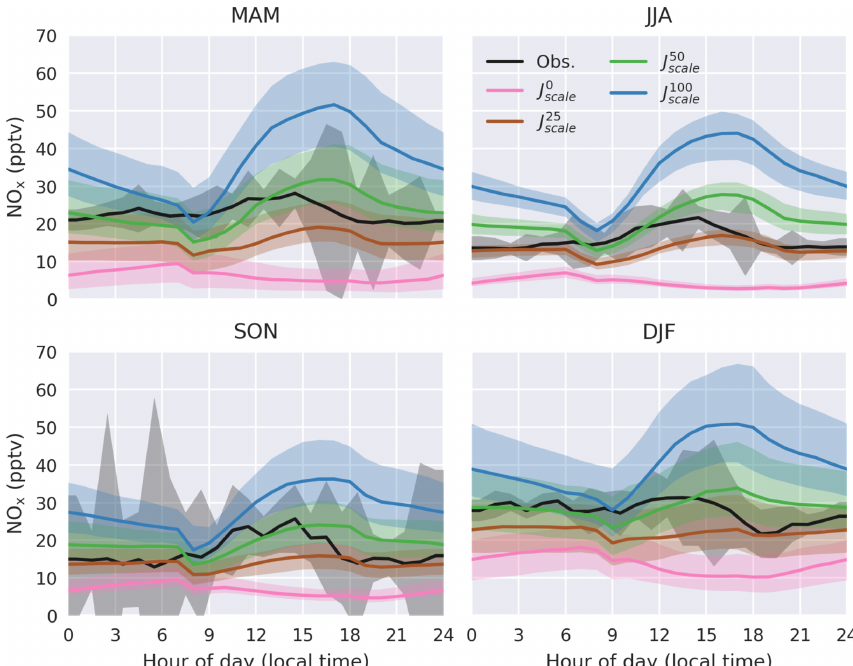
Figure 5. Observed and modeled diurnal cycles of NO x at CVAO during different seasons (MAM: March, April, May; JJA: June, July, shaded regions show first and third quartiles of model values and standard error of observations. Model simulations assume a HONO : NO 2 molar yield of 0 . 67 : 0 . 33 from NITs